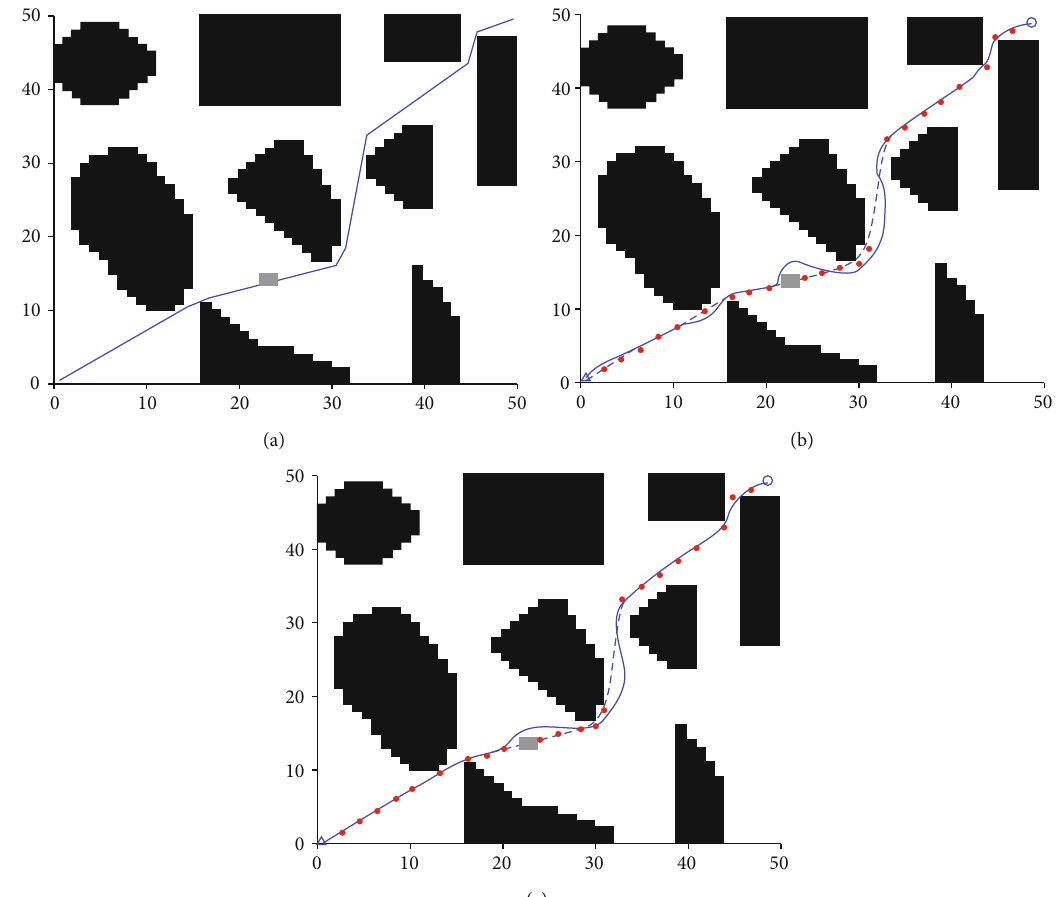
Figure 11: Comparison of the path planning algorithms on an unknown map. (a) Improved A ∗ algorithm. (b) Standard DWA algorithm. (c) Fusion of improved A ∗ and DWA